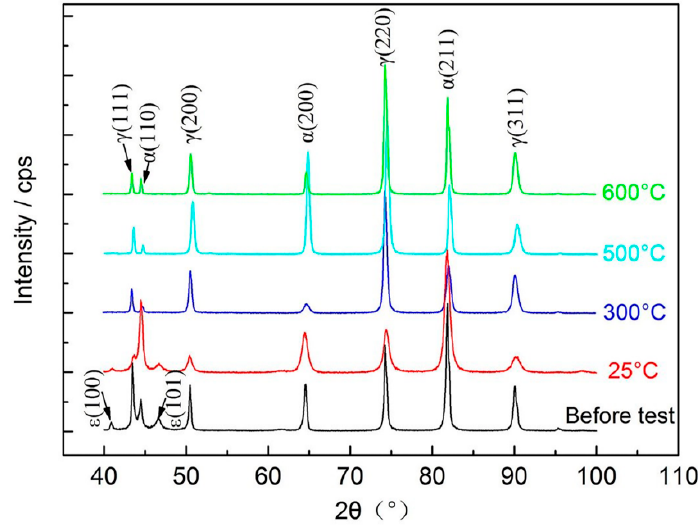
Figure 3. XRD patterns of the investigated steel before and after tensile deformation at different temperatures. ((Before test, ε = 0), (25 °C, ε = 55%), (300 °C, ε = 36%), (500 °C, ε = 44%), (600 °C, ε = 64%)). Table 2. Volume fraction of constituent phases estimated by X-ray diffraction (vol%).